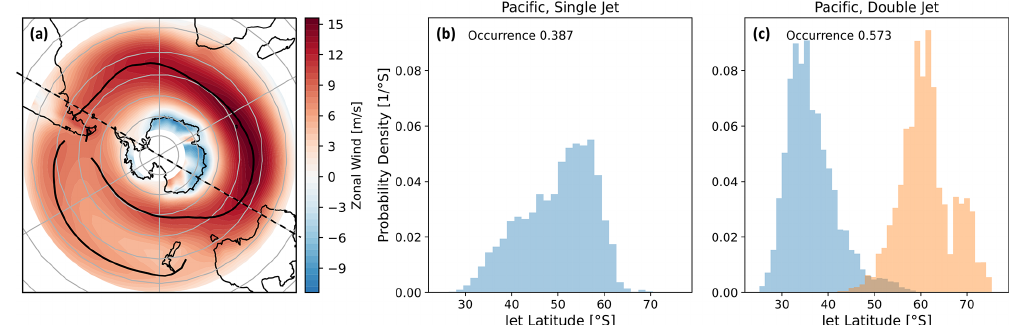
Figure 3. (a) The 850hPa climatological zonal wind averaged over all CMIP6 models; the solid black lines trace the jet positions. The dashed black line divides the hemisphere into the Indo-Atlantic and the Pacific sectors. (b) Jet latitude probability density for days with a single-jet structure in the Pacific; (c) same as panel (b) but for days with a double-jet